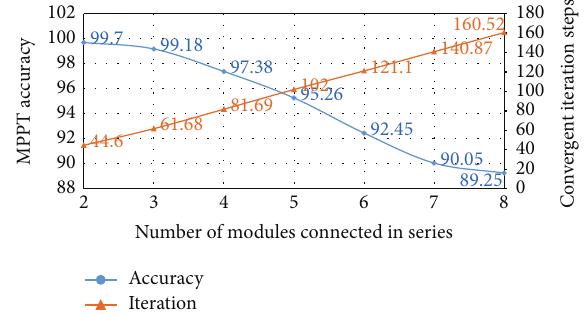
Figure 13: MPPT accuracy and convergent speed as a function of module number in the distributed